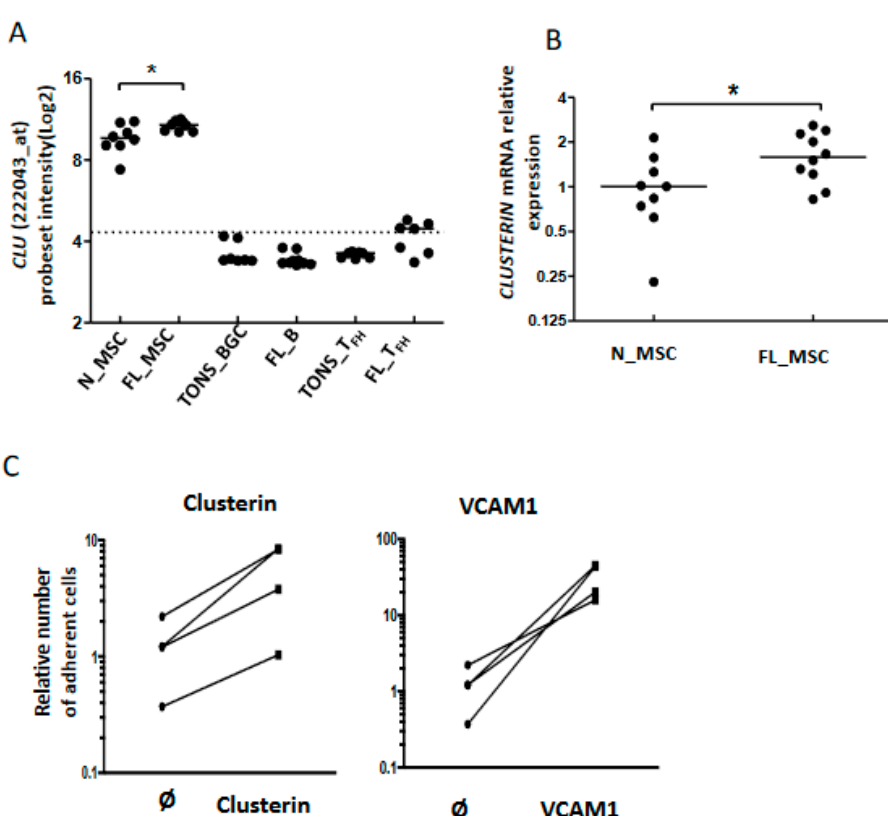
Figure 6. Adhesion of B cells to stromal cells via clusterin expression. Clusterin mRNA expression by stromal cells and up-regulation in the FL context evaluated by Affymetrix probeset intensity ( A ) and confirmed by qRT-PCR ( B ), * p < 0.05; ( C ): CFSE-labeled FL-B cells were incubated for 2 h in wells pre-coated with or without (Ø) clusterin (left), or VCAM1-Fc chimera protein as a control (right). The number of adherent cells was quantified using a fluorescence reader. The number of adherent naive B cells in wells without any coated protein was assigned as 1.